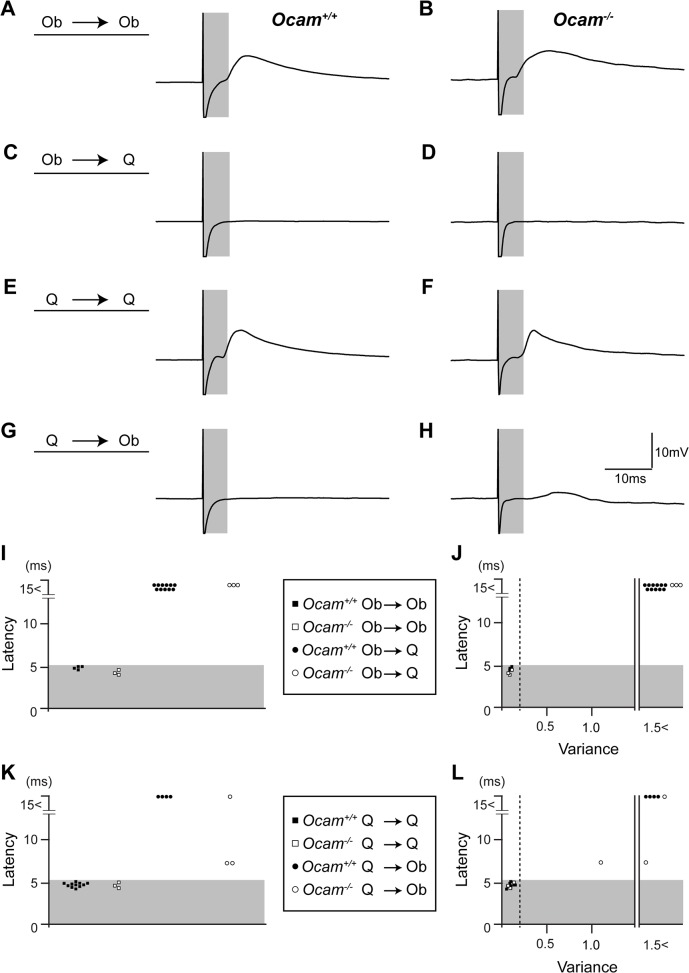
Specificity of monosynaptic sensory-motor connections is not altered in Ocam mutant mice.(A-H) Synaptic potentials recorded from individual motor neurons following muscle nerve stimulation from P6–7 Ocam
+/+ (A, C, E, G) and Ocam
−/− (B, D, F, H) mice. All traces shown are average responses from single motor neurons derived from 20 trials at 1Hz. Representative recordings are shown for the following motor neuron recording and nerve stimulation pairs: (A, B) Ob motor neuron recording following Ob nerve stimulation; (C, D) Q motor neuron recording following Ob nerve stimulation; (E, F) Q motor neuron recording following Q nerve stimulation; and (G, H) Q motor neuron recording following Ob nerve stimulation. (I-L) Quantification of the latencies (I, K) and the variance (J, L) of the onset of monosynaptic EPSPs is shown. Gray bars in all panels indicate the monosynaptic latency windows.